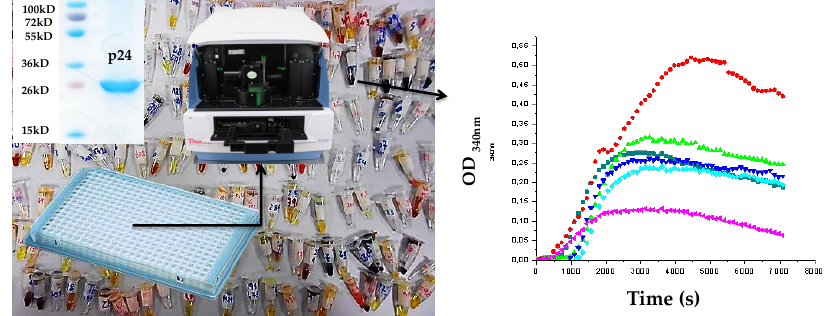
Figure 3. Left panel: general representation of the optimized screening in the assembly assay. Purity of p24 is shown in the inset. Right panel: two discriminable behaviors are visible compared to the control (in dark blue). In red is the enhancement of the process, and in pink is the inhibition of the process. The green and light blue curves are typical for compounds with no effect on the p24